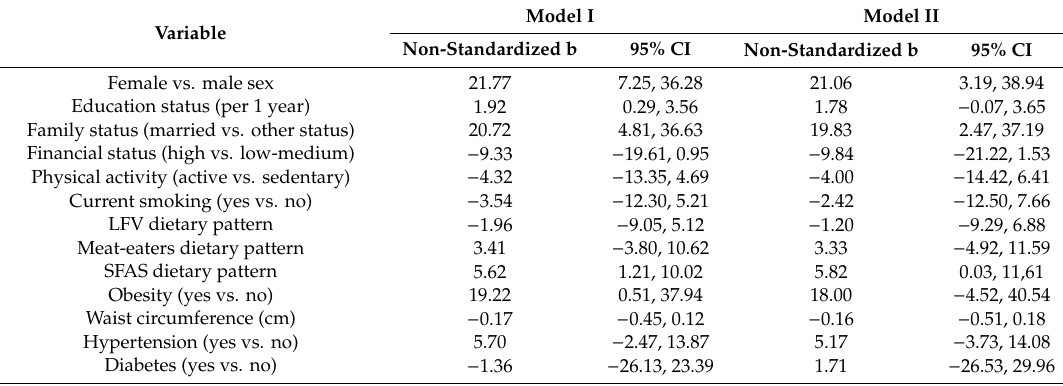
Table 4. Correlates of anxiety among adults aged ≥ 50 years estimated by additive multivariable linear regression (Model I and Model II), in the ATTICA study, n =